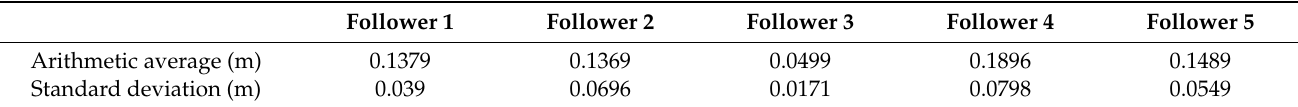
Table 4. The average distance and standard deviation between the follower and leader routes at a speed of 1.95 m/s.